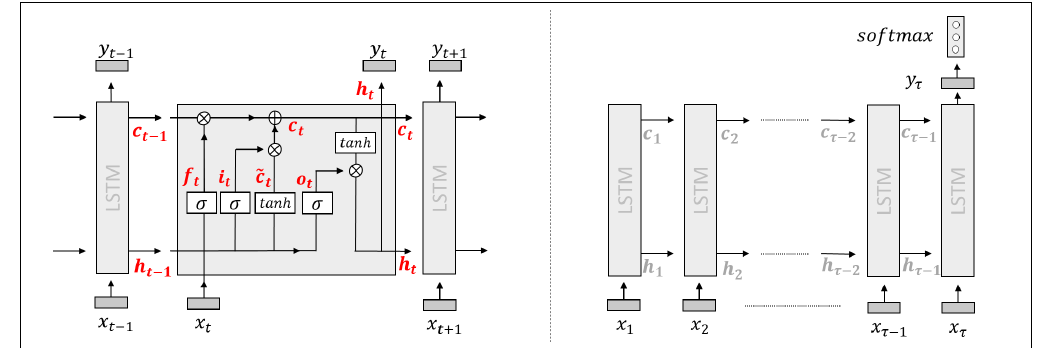
Figure 1. Schemes. Information flow inside Long Short-Term Memory (LSTM) ( left ) and unrolled LSTM where the output is computed at the last recurrence ( right ).